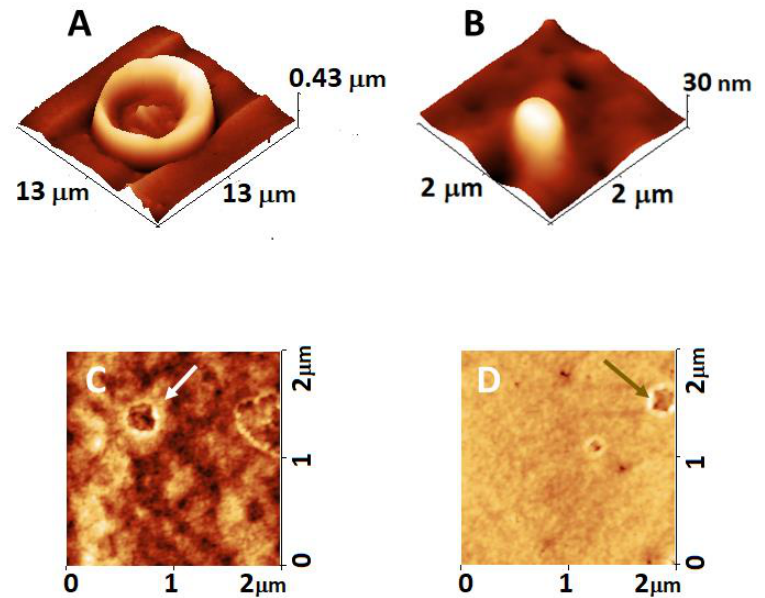
Figure 4. Example of 3D images of a whole RBC ( A ) and RBC membrane patch scanned in an area of 2 × 2 µm 2 ( B ) from a patient with preeclampsia, representing the initial formation of vesicles. Panels ( C , D ) illustrate the disturbances on the membrane surface after vesicle extrusion (denoted with arrows). The scale bar in panel ( A ) is 13 µm, and in panels ( B – D ) is 2 µm.